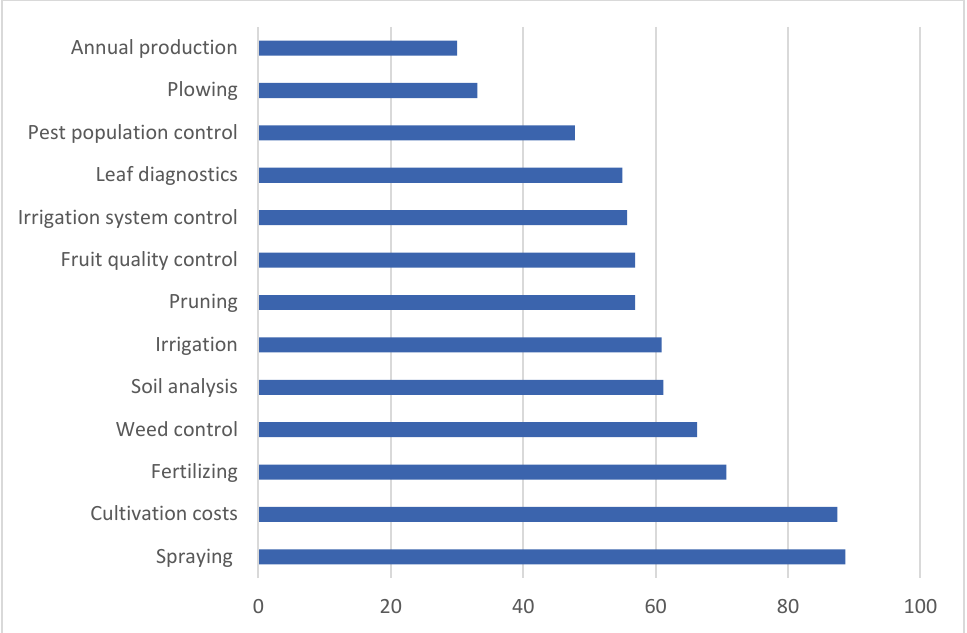
Figure 2. Recording frequency of farming activities by citrus growers.